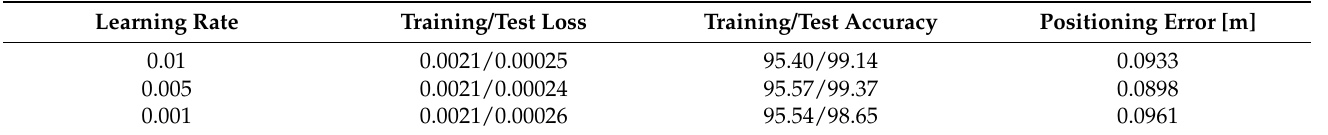
Table 4. Performance analysis for various learning rates.